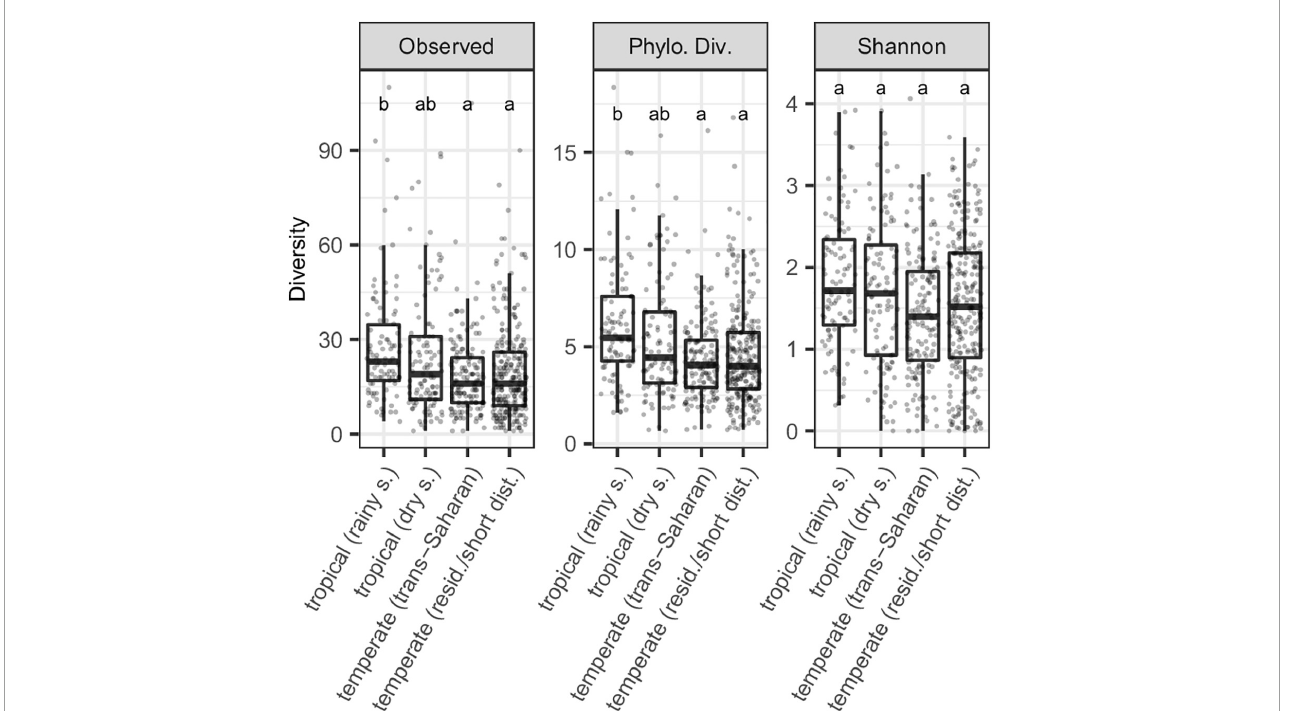
FIGURE1 Gut microbiota (GM) alpha diversity variation for three diversity measures (number of observed OTUs, phylogenetic diversity and Shannon diversity) in tropical passerines sampled during the wet or rainy season, temperate trans-Saharan migrants and temperate residents/short-distance migrants. Different letters above the bars indicate significant differences between the two host groups according to Tukey post-hoc tests ( p < 0.05), whereas the presence of at least one common letter indicates a non-significant difference.